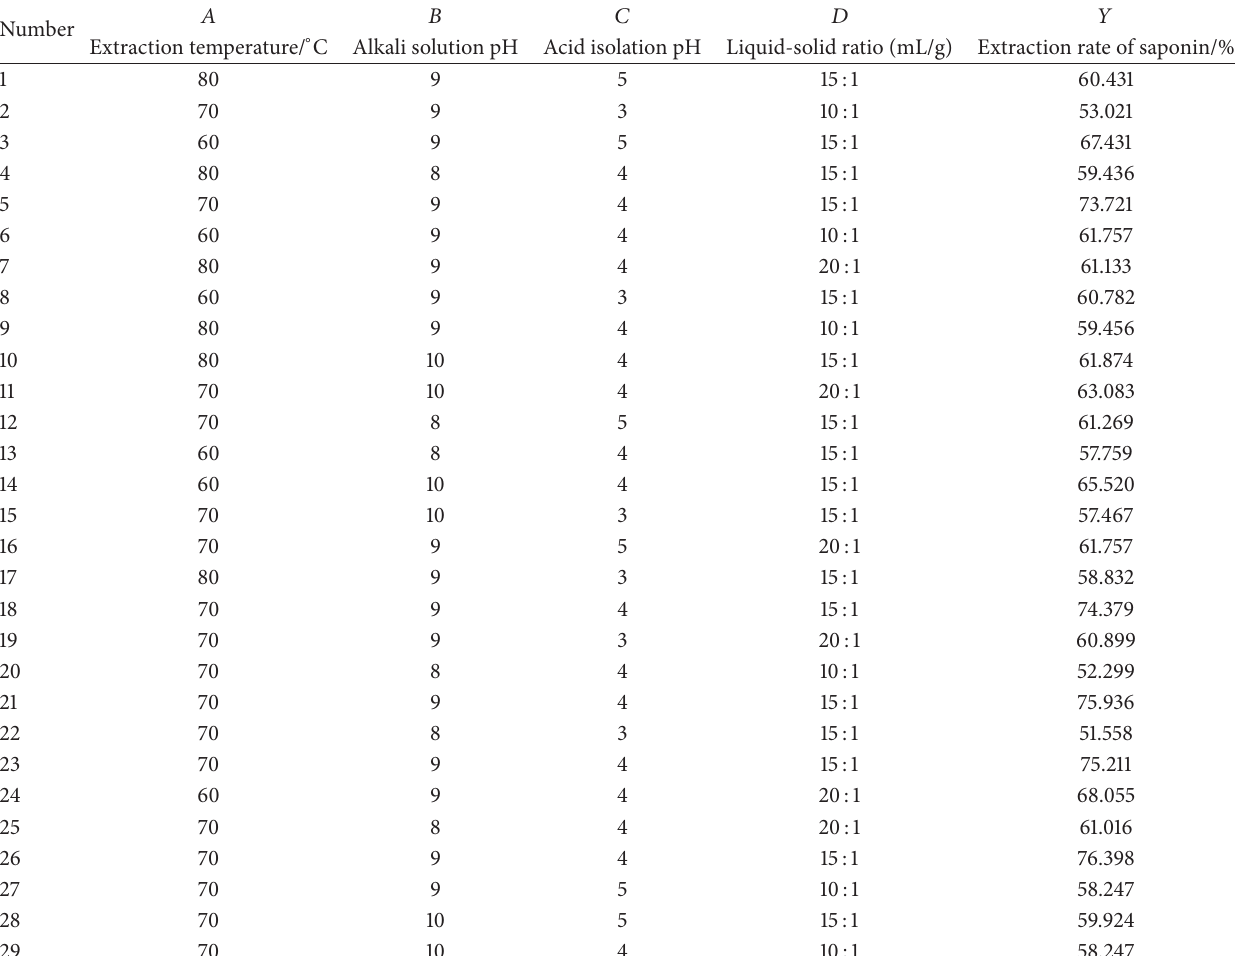
Table 2: The design and experimental results of response surface analysis for extracting saponin from Camellia oleifera cake. 𝐴 𝐵 𝐶 𝐷 𝑌 Number